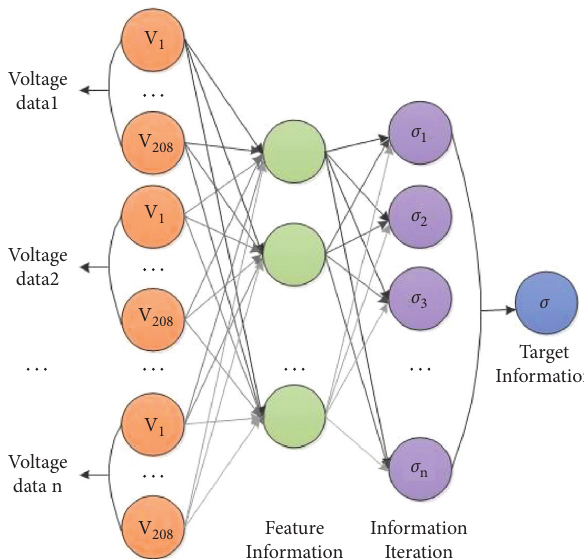
Figure 5: Schematic diagram of the super-resolution reconstructed image.